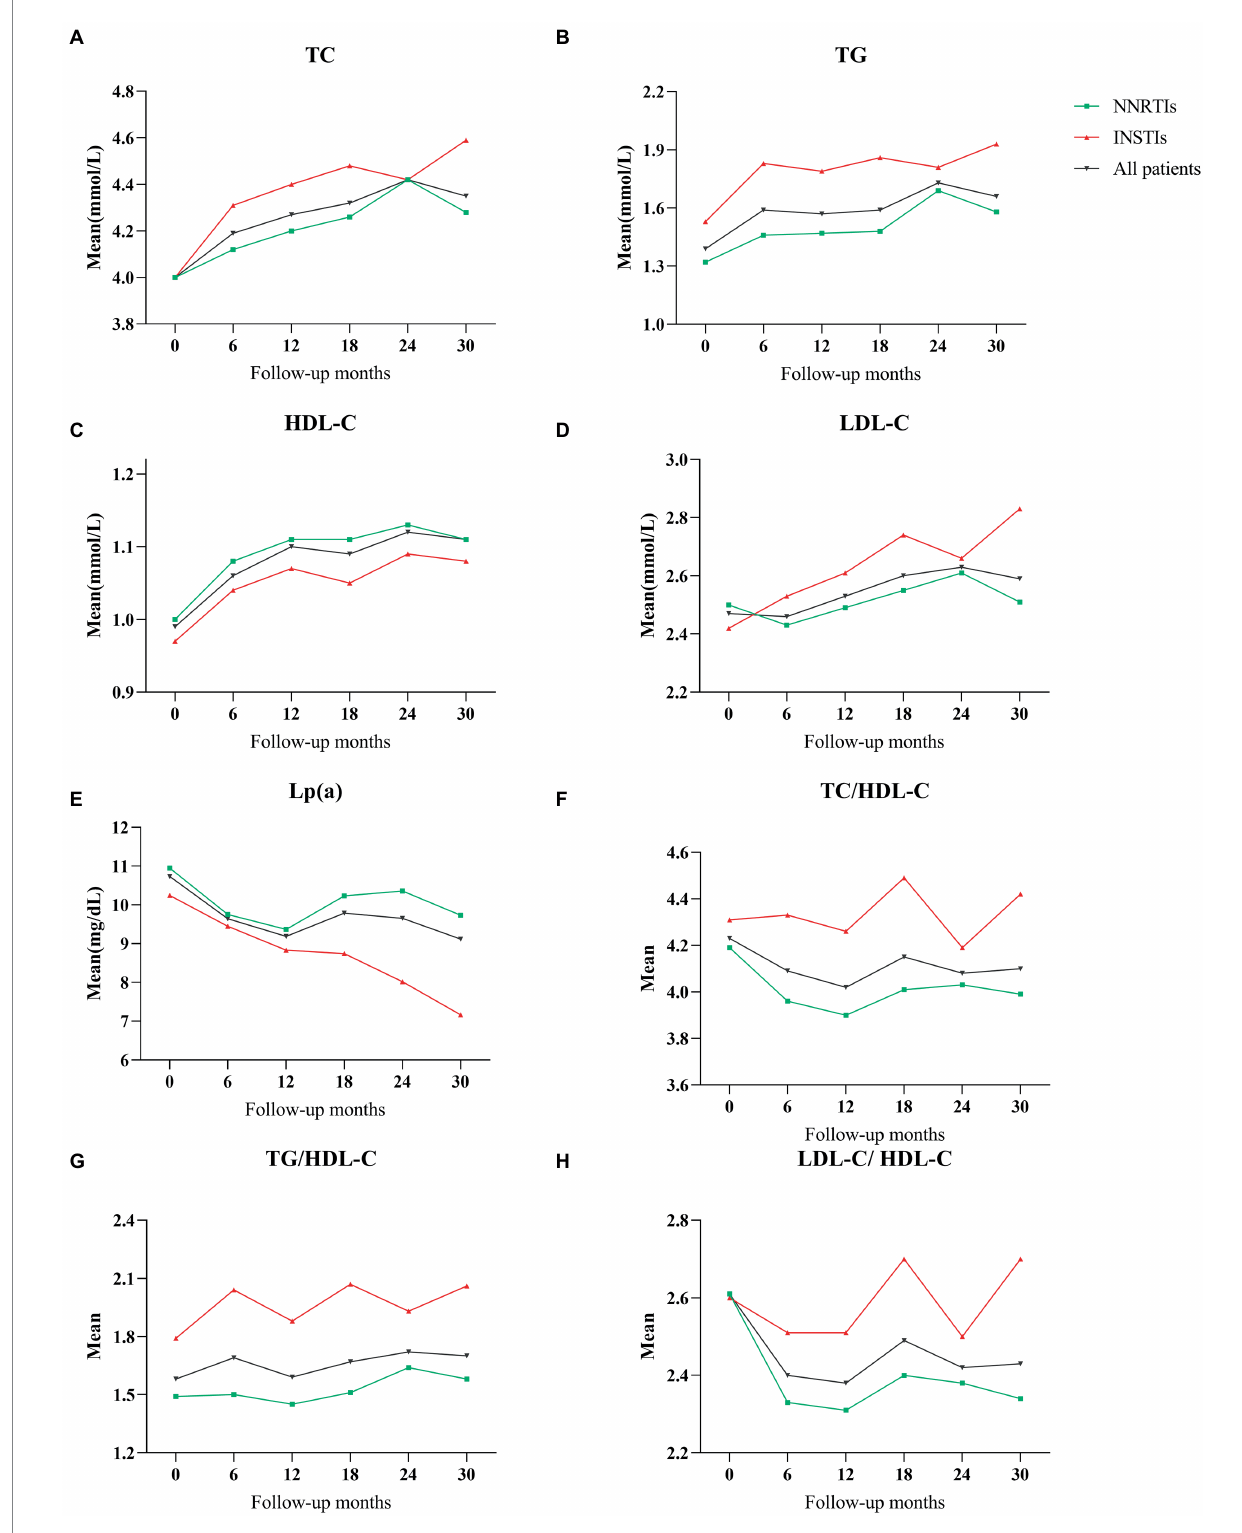
FIGURE 1 (A) The mean values of total cholesterol during follow-up period with NNRTIs vs. INSTIs. (B) Triglycerides throughout the follow-up period. (C) HDL- cholesterol. (D) LDL-cholesterol. (E) Lipoprotein(a). (F) TC/HDL-C ratio. (G) TG/HDL-C ratio. (H) LDL-C/HDL-C